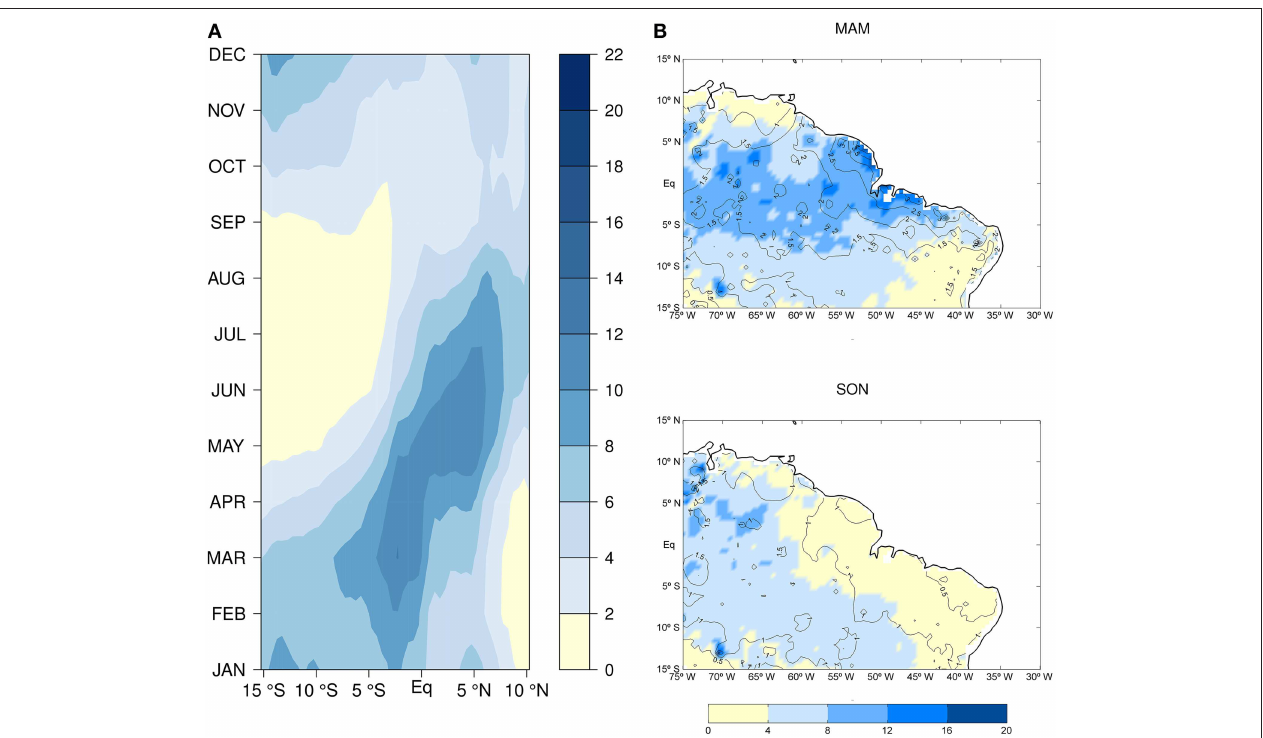
FIGURE 1 | (A) Hövmoller diagram with the evolution in time and latitude of the average precipitation per month in the region of 35–65 W. (B) Seasonal average of rainfall for UDel in the boreal spring months, March–May, (top panel) and autumn months September–November (bottom panel). Units are mm/day. Contours show the standard